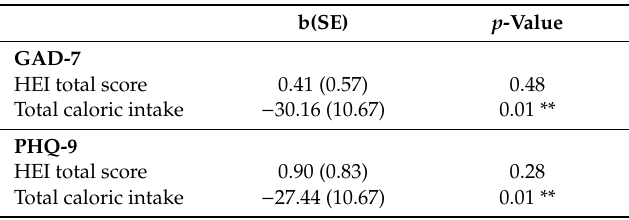
Table 3. E ff ects of anxiety on diet quality and total calorie consumption and depression on diet quality and total calorie consumption (Hypotheses